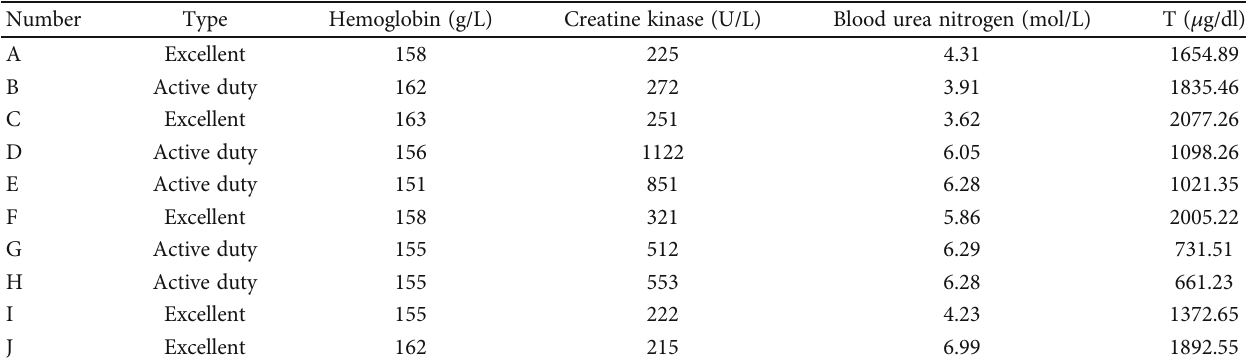
Table 1: Biochemical index data of human health in sports training.